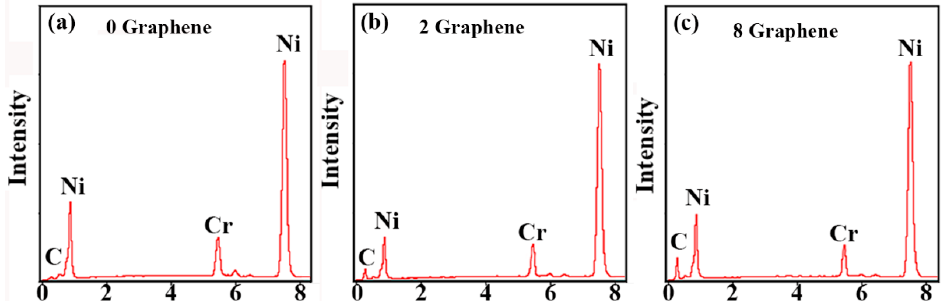
Figure 4. Energy-dispersive spectroscopy (EDS) analysis of the Ni–Cr–graphene coatings electrodeposited at different graphene concentrations: 0 ( a ), 2 ( b ), and 8 ( c ) g/L.